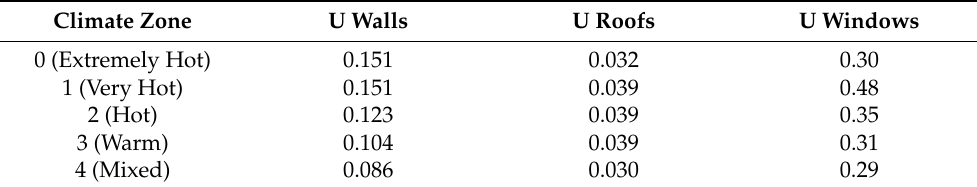
Table 5. Thermal transmittance (W/m 2 K) according to ASHRAE